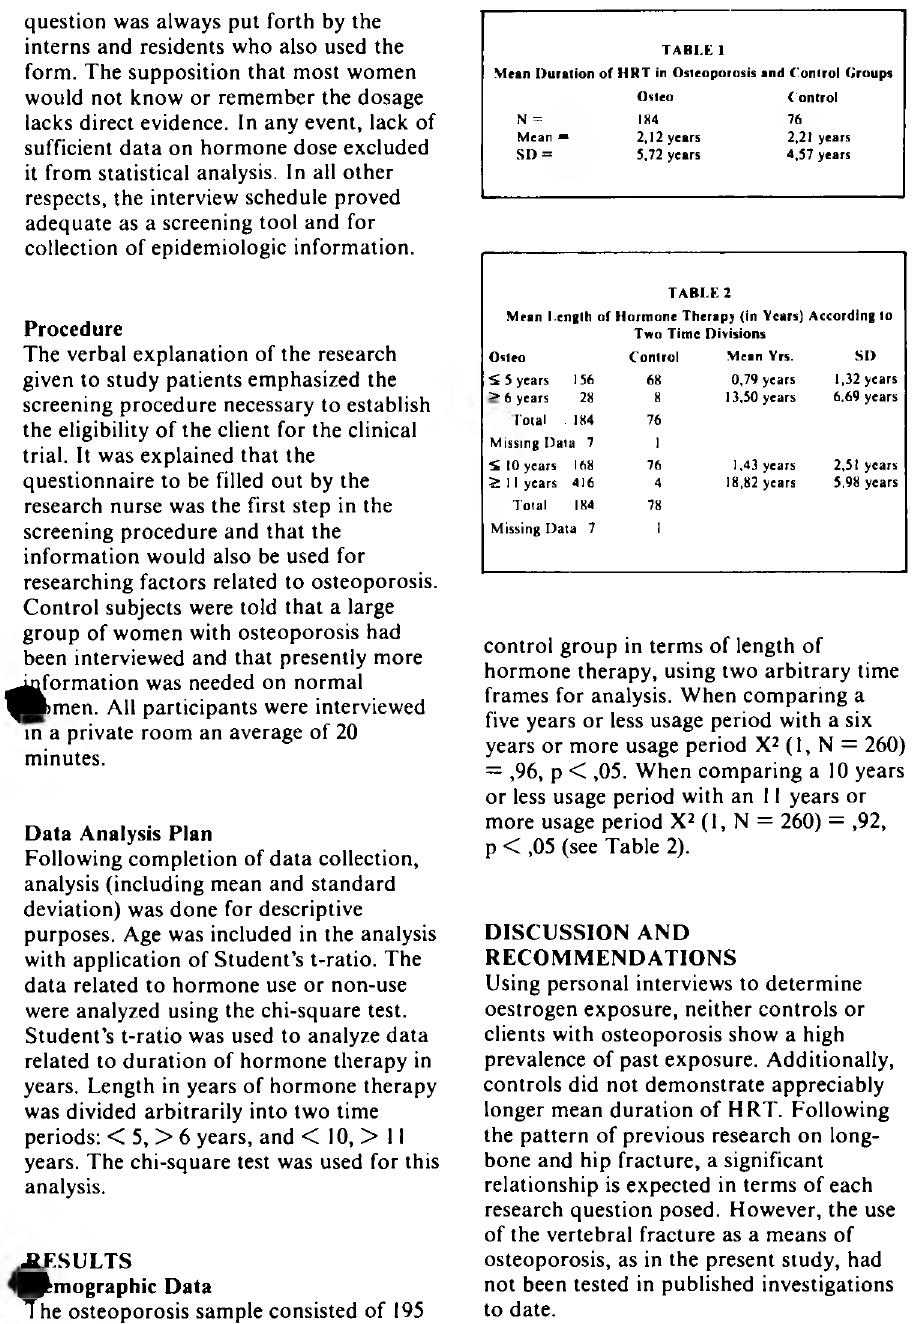
TABLE 2 Mean l.ength of Hormone Therapy (in Years) According to Two Time